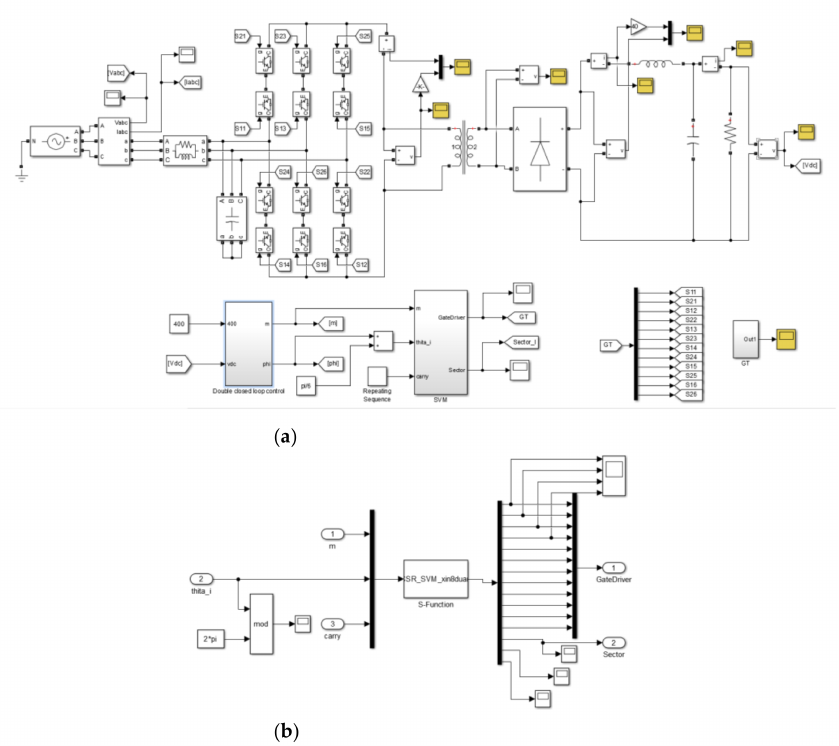
Figure 10. MATLAB/Simulink model. ( a ) Main circuit and control module. ( b ) S-function of SVPWM.